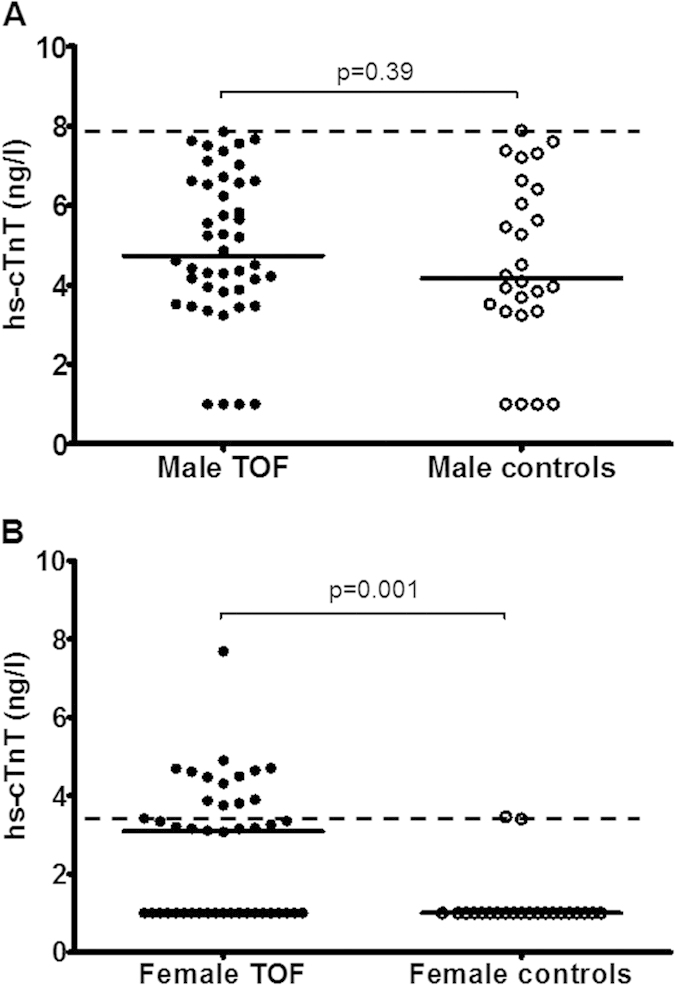
Scatter plots showing plasma high sensitivity cardiac troponin T (hs-cTnT) levels in (A) male and (B) female patients after repair of tetralogy of Fallot (TOF) and control subjects. Solid lines represent the median, dotted lines represent the 99th percentile derived from non-parametric estimation.